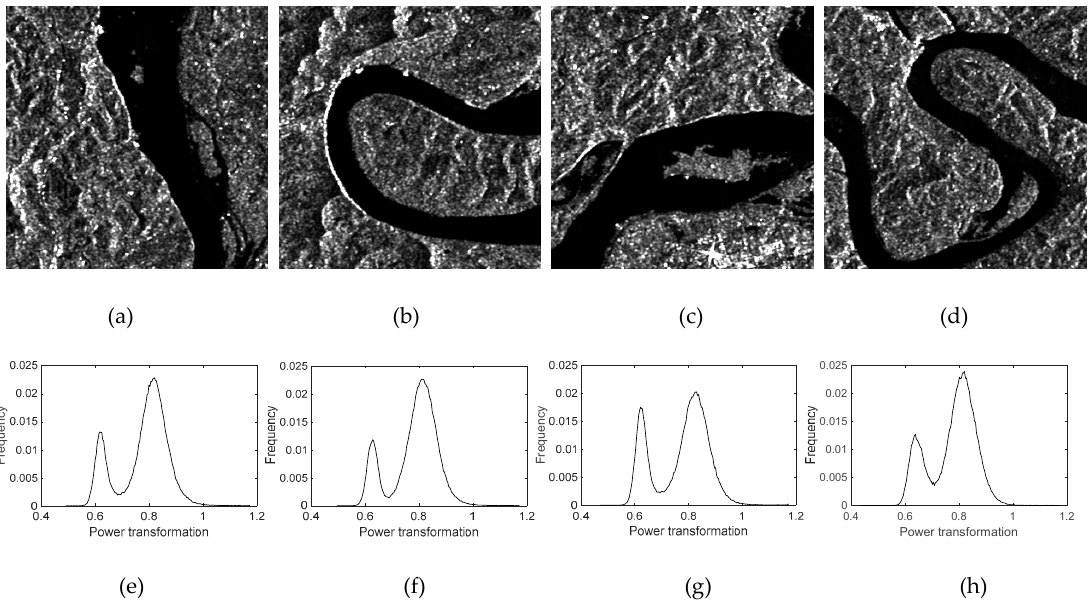
Figure 4. ( a – d ) The zoomed images of target regions numbered by 1, 2, 3, and 4 in Figure 3c; ( e – h ) the corresponding histograms. Table 2. Water mode, LM threshold, and KI threshold of the numbered target regions in Figure 3c. Number Water